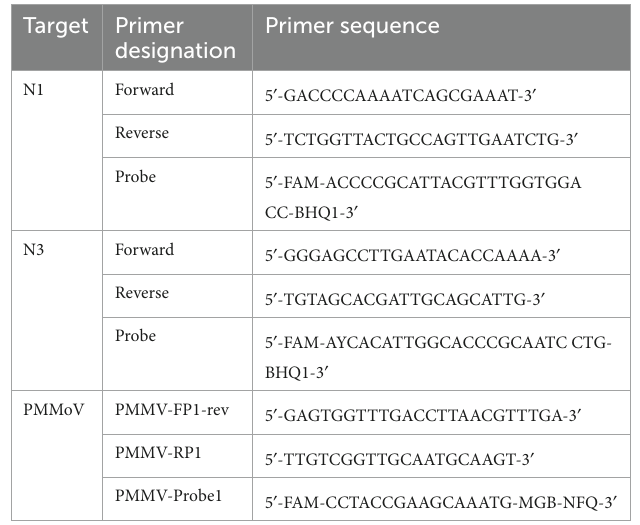
TABLE 1 RT-qPCR primer and probe sequences.